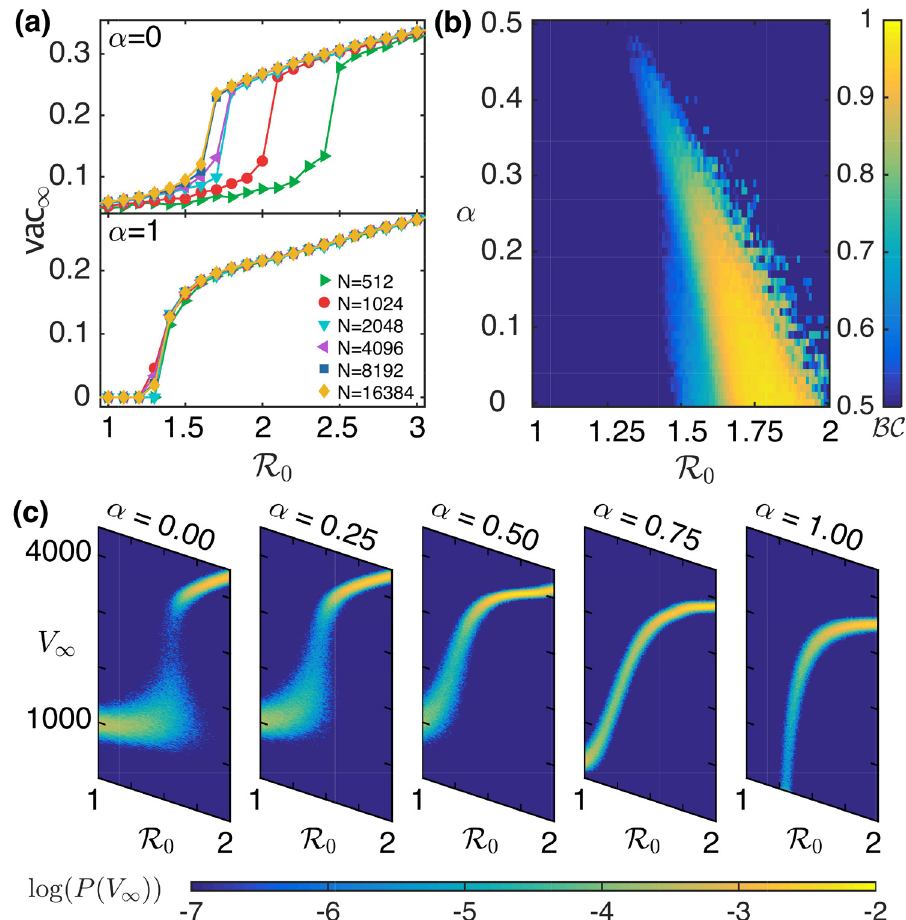
Fig 4. Use of local or global information by agents can qualitatively alter the collective vaccination outcome to epidemics. (a) Assessing the dependence of vac 1 in a network having average node degree h k i = 10 on population size N . The results are shown for α = 0 (top) and α = 1 (bottom). (b) Bimodality coefficient BC for the probability distribution of V 1 calculated over 2000 trials for Erd ő s-Re´nyi networks with N = 16384 and h k i = 10, and shown over the range of values of R and α . (c) Probability distribution of V 1 as a function of R , calculated over 2000 trials, and 0 0 shown for different values of α